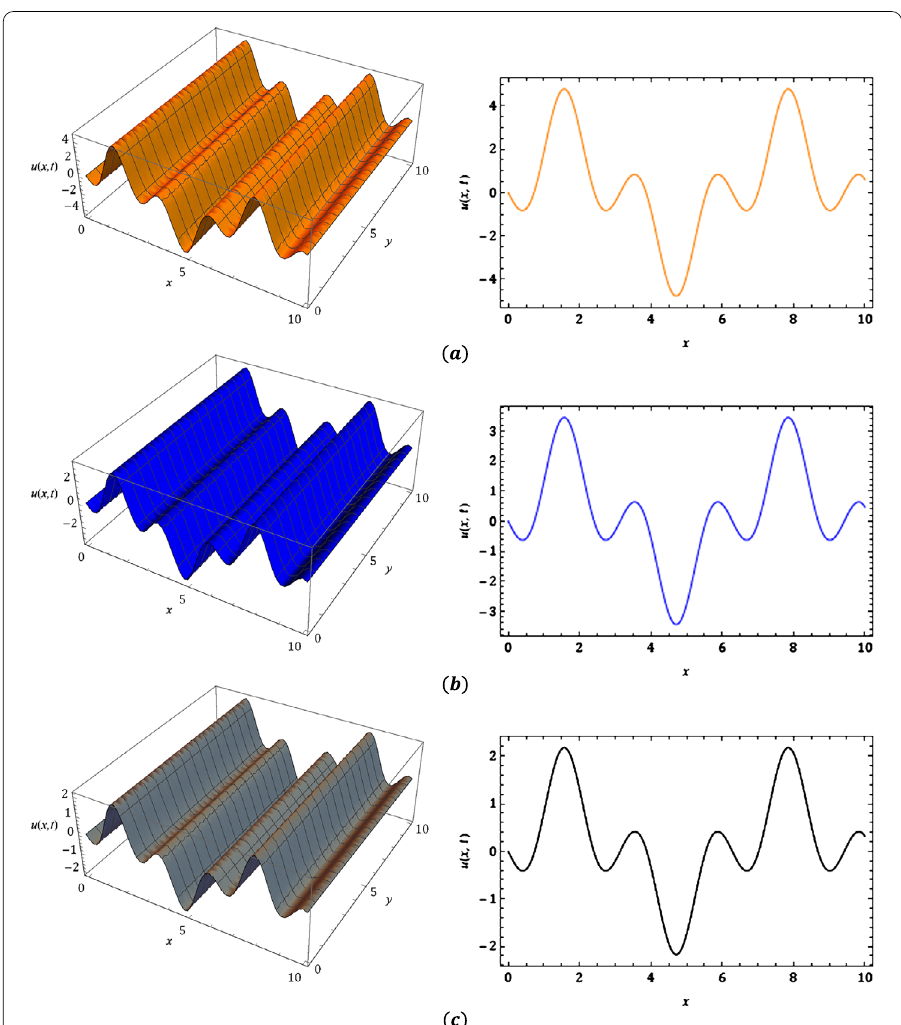
Figure 1 Nature of q -HATM solution in terms of 3D and 2D for Case 1 with y = 1 at (cid:2) = –1, n = 1 and t = 1 with ( a ) α = 0.50, ( b ) α = 0.75 and ( c ) α = 1